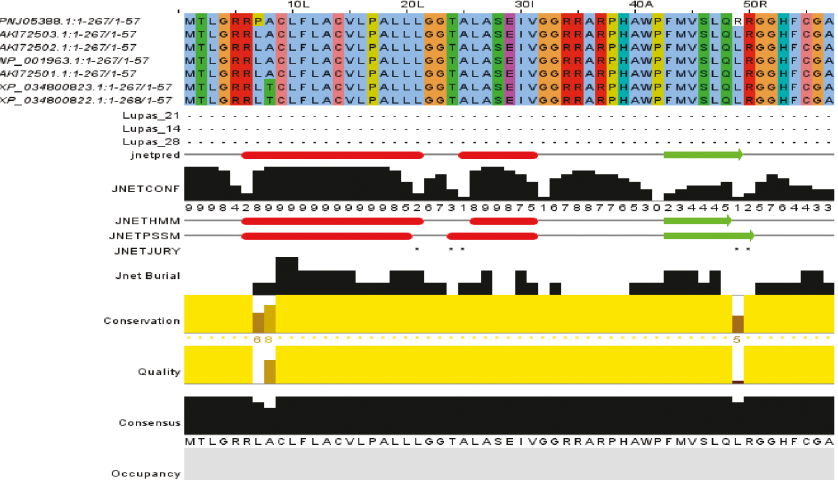
Figure 5: Amino acid alignment of human ELANE (UniProt ID:P08246) along with its homologues in phylogenetically close species in AK172501.1, XP 034800823.1, and XP 034800822.1. Solid horizontal bars indicate conserved sequence motifs, and residues with asterisk ( mark indicate evolutionarily conserved amino acids. The amino acid identities were colored according to the Clustal color scheme, and the conservation index at each alignment position was provided by Jalview.